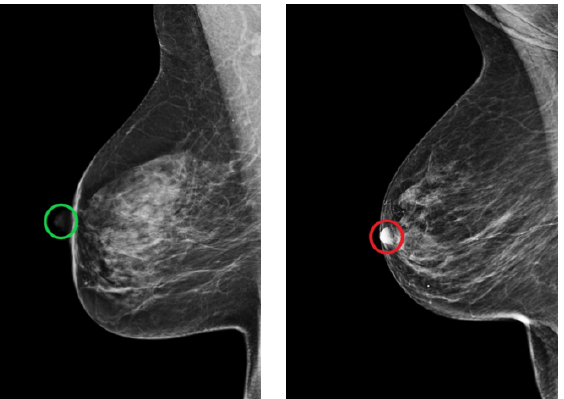
Figure 22. Example of adequately (green circle) and inadequately (red circle) positioned MLO views regarding the position of the nipple. ( Left ): in profile. ( Right ): projected onto the parenchyma.